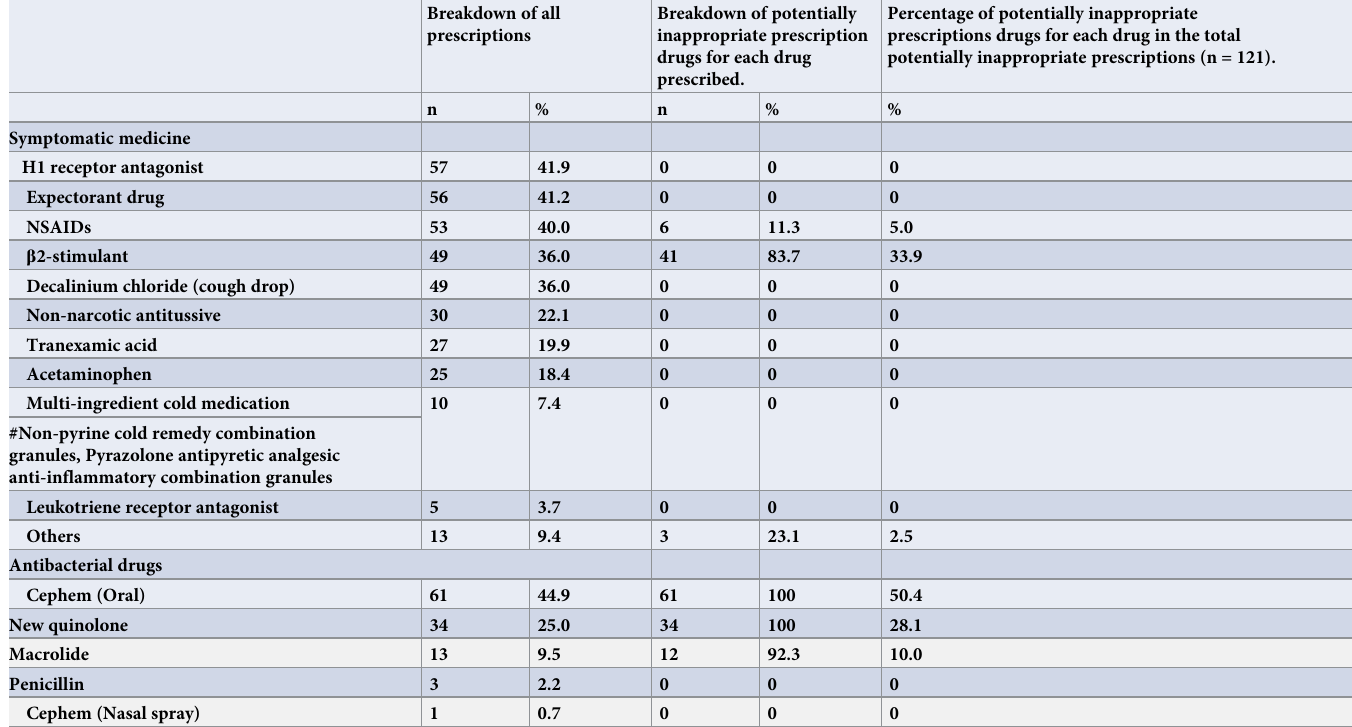
Breakdown of all Breakdown of potentially Percentage of potentially inappropriate prescriptions inappropriate prescription prescriptions drugs for each drug in the total drugs for each drug potentially inappropriate prescriptions (n = 121). prescribed.